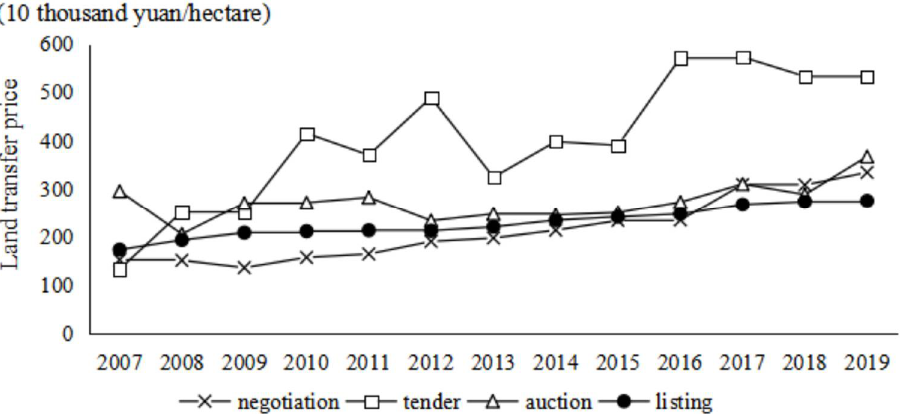
Figure 2. Price of industrial land transferred by different modes. 4 Data source: Chinese land market network (http://www.landchina.com/ accessed on 30 July 2020).